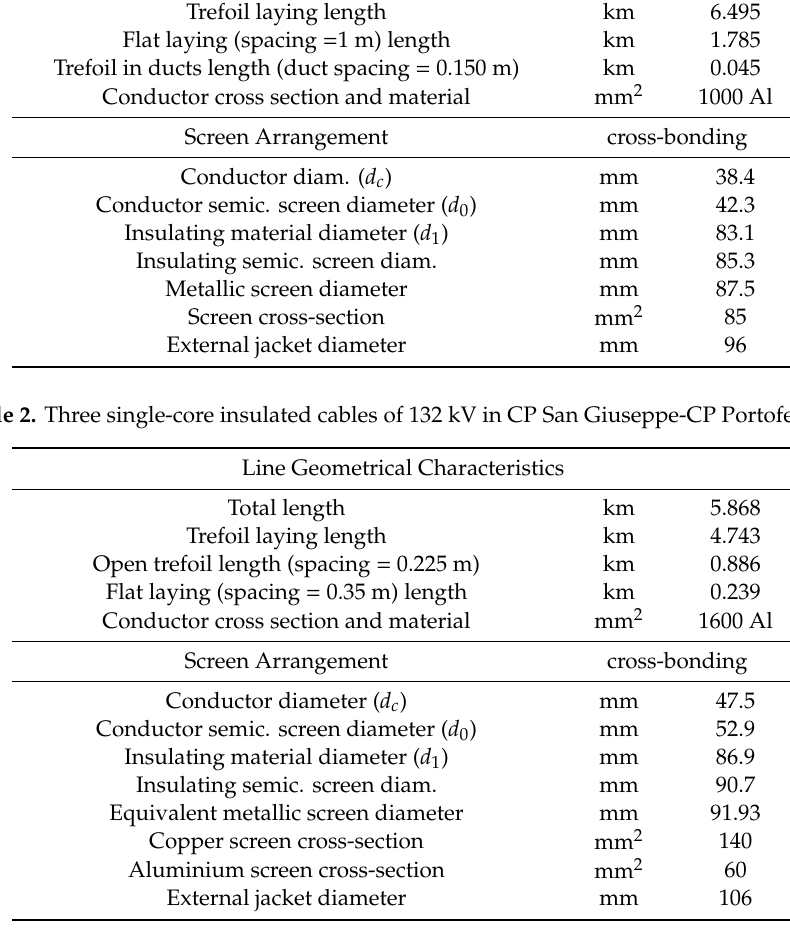
Table 3. Three single-core insulated cables of 132 kV in SE Camin-CP